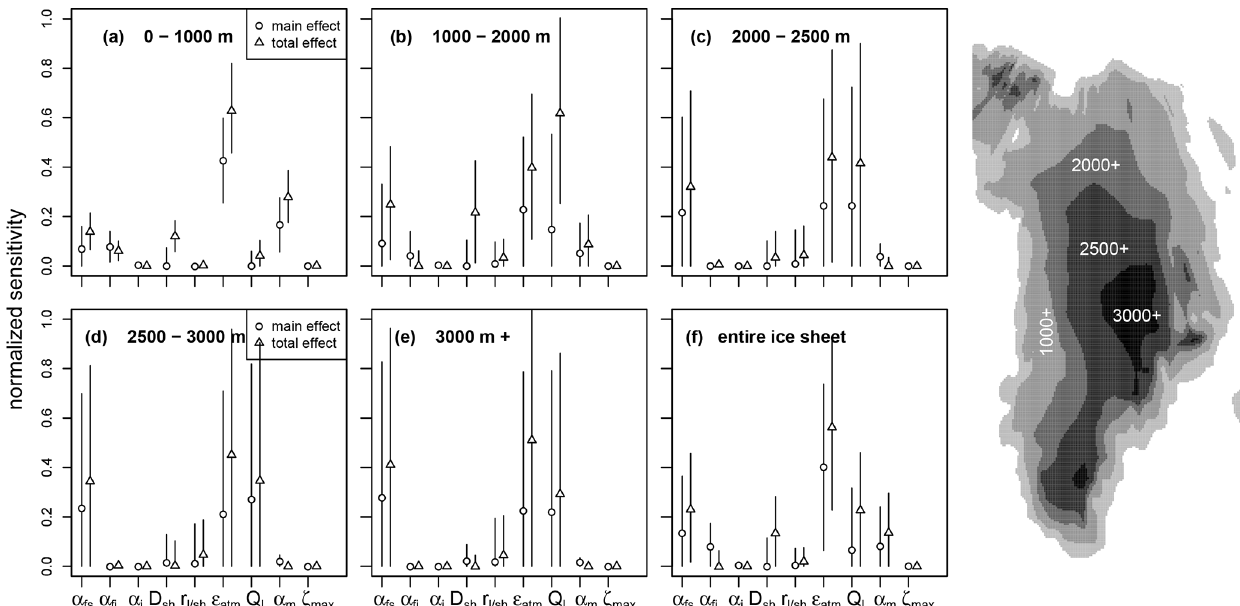
Figure A1. The global sensitivity analysis of the LGM SMB provides the main-order effect (circle) and the total effect (triangle). The two indices are displayed for all nine parameters over the different elevation bands ranging from 0–1000, 1000–2000, 2000–2500, and 2500– 3000 to above 3000m and for the entire ice sheet. The symbol represents the mean value of the sensitivity index with the bars as ± 1 σ . The elevation bands of the LGM topography over Greenland are displayed on the right; the analysis is only performed for cells where ice is present. The uncertainty in the sensitivity indices is larger than for the PD due to the smaller ensemble